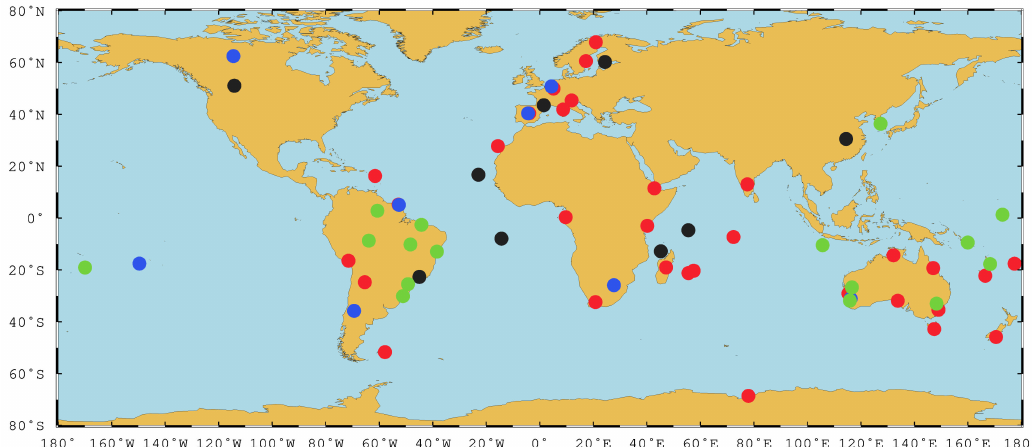
Figure 10. The stations distribution of the four selected receiver types. Red: SEPT POLARX5 5.3.2; blue: SEPT POLARX5TR 5.3.2; black: TRIMBEL NETR9 5.43; green: TRIMBLE NETR9